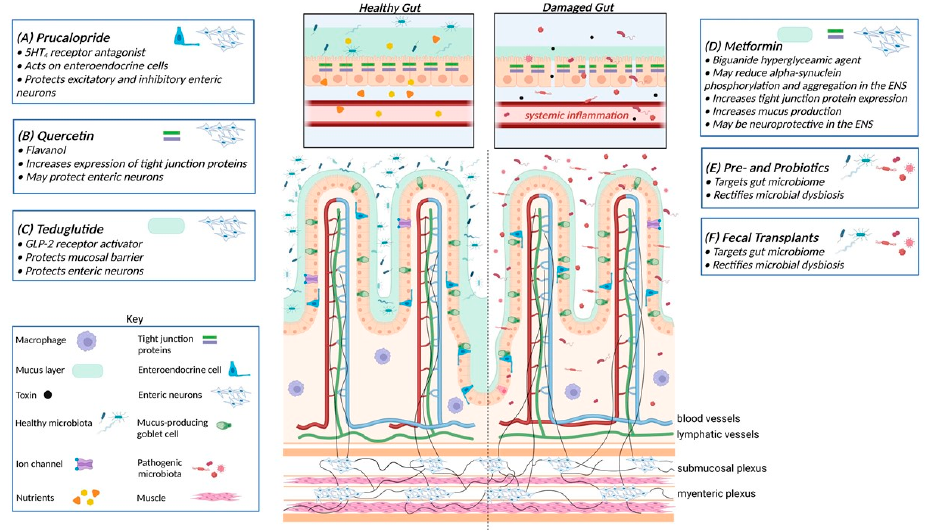
Figure 2. Potential new therapeutics for PD ‐ related GI dysfunctions and sites of action.